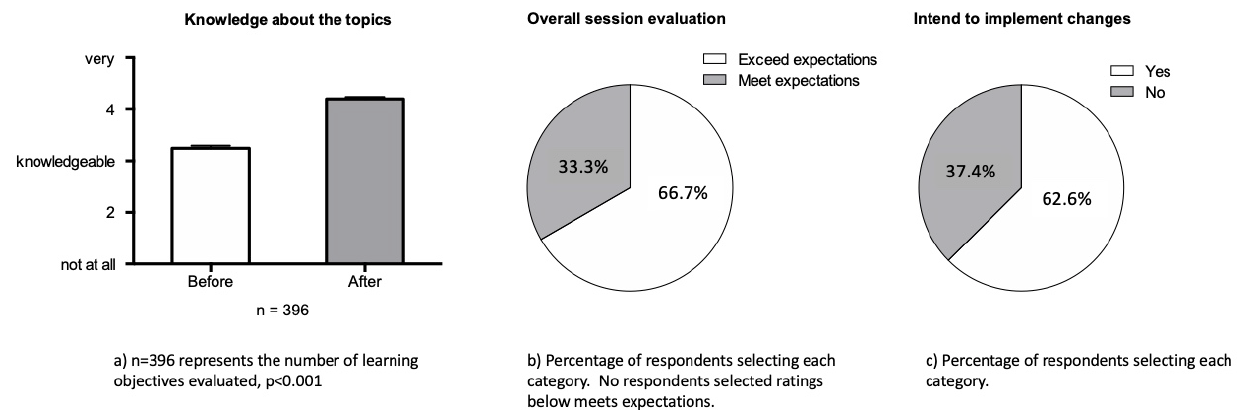
Figure 2. Attendee evaluation of the educational series. a) Knowledge about the topics. n = 396